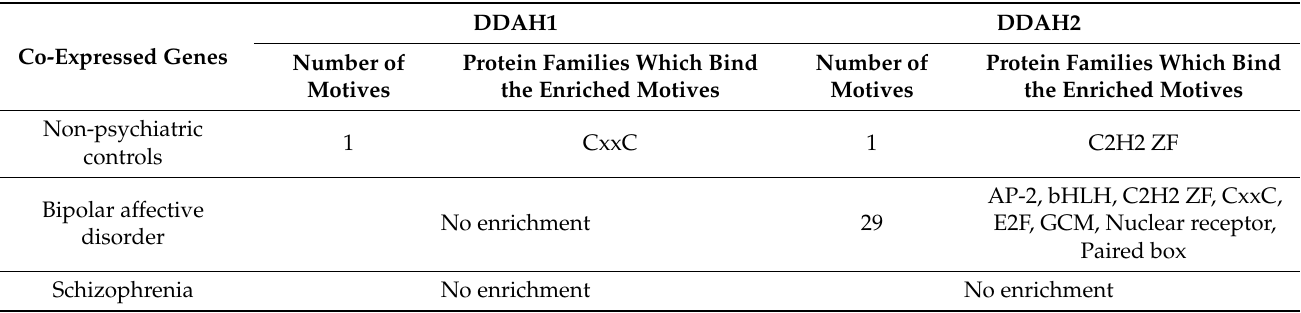
Table 3. Enriched promoter motifs in genes co-expressed with DDAH1 or DDAH2 in the dorsolateral prefrontal cortex of non-psychiatric control subjects, patients with bipolar disorder or